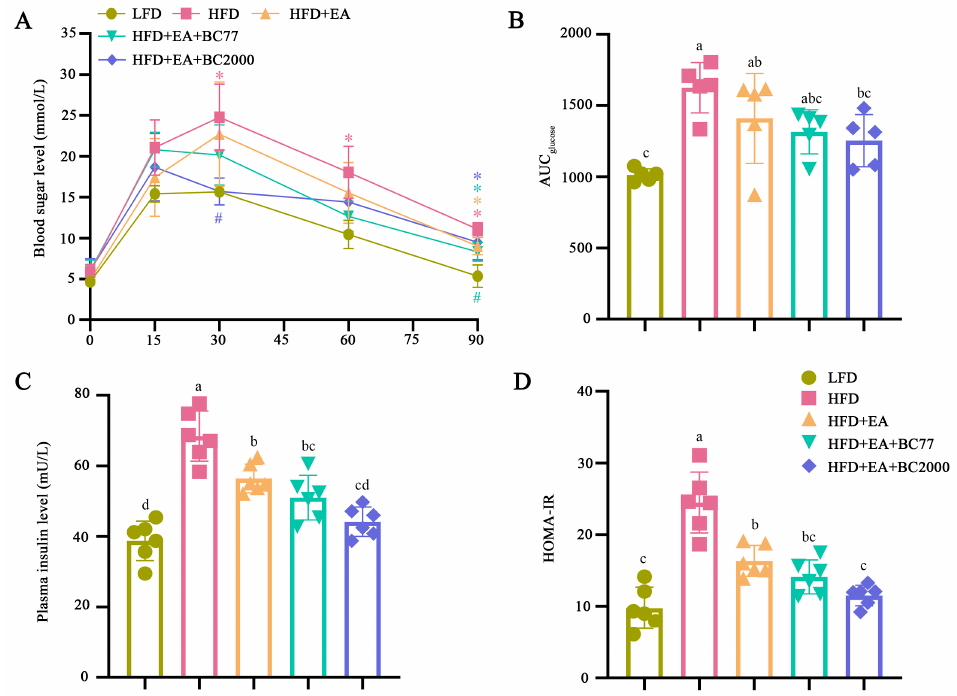
Figure 2. Impact of BC2000 on glucose homeostasis and insulin resistance in obese mice: ( A ) blood sugar level; ( B ) AUC; ( C ) plasma insulin level; ( D ) HOMA-IR. * indicates a significant difference compared with the LFD group ( p < 0.05). # indicates a significant difference compared with the HFD group ( p < 0.05). Different lowercase letters above bars indicate significant differences among groups ( p < 0.05). Blood sugar level and AUC (n = 5/group). Plasma insulin level and HOMA-IR (n = 6/group). Values show mean ± SD. Tukey’s test based on a one-way analysis of variance was